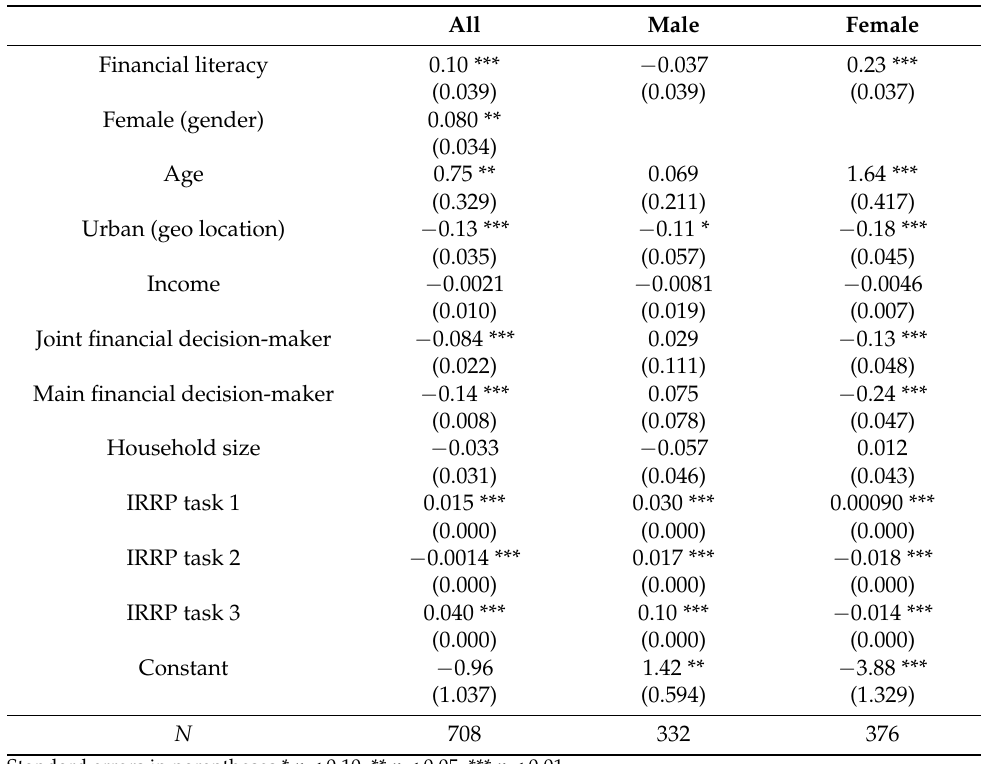
Table 5. RE panel regression: dependent variable